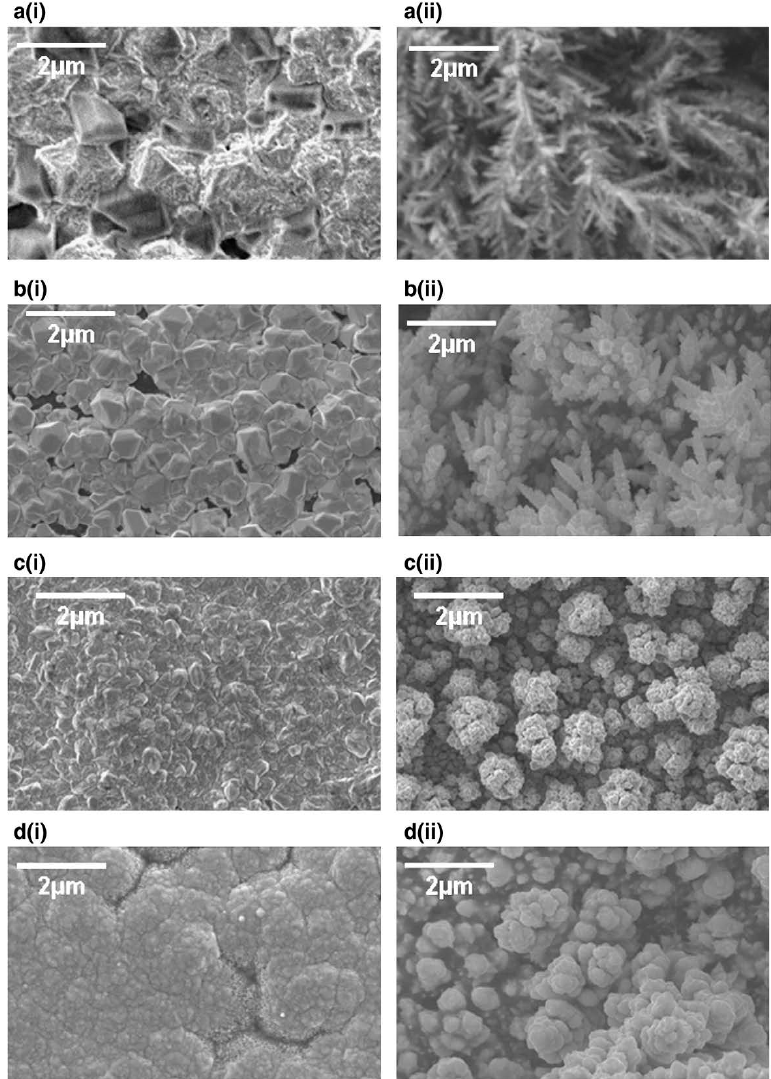
Figure 8. SEM images of copper deposits with (i) and without (ii) sonication at ( a ) 25, ( b ) 19.5, ( c ) − 1 and ( d ) − 3 °C. Reprinted from [36] with permission from